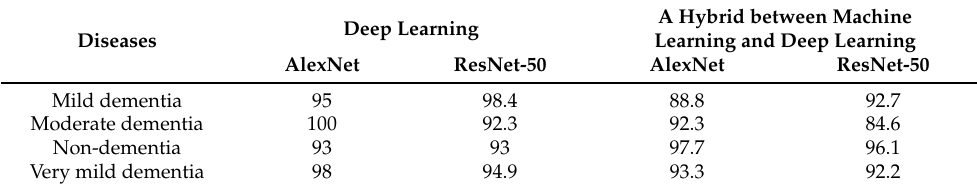
Table 11. Performance evaluation results on Alzheimer’s MRI